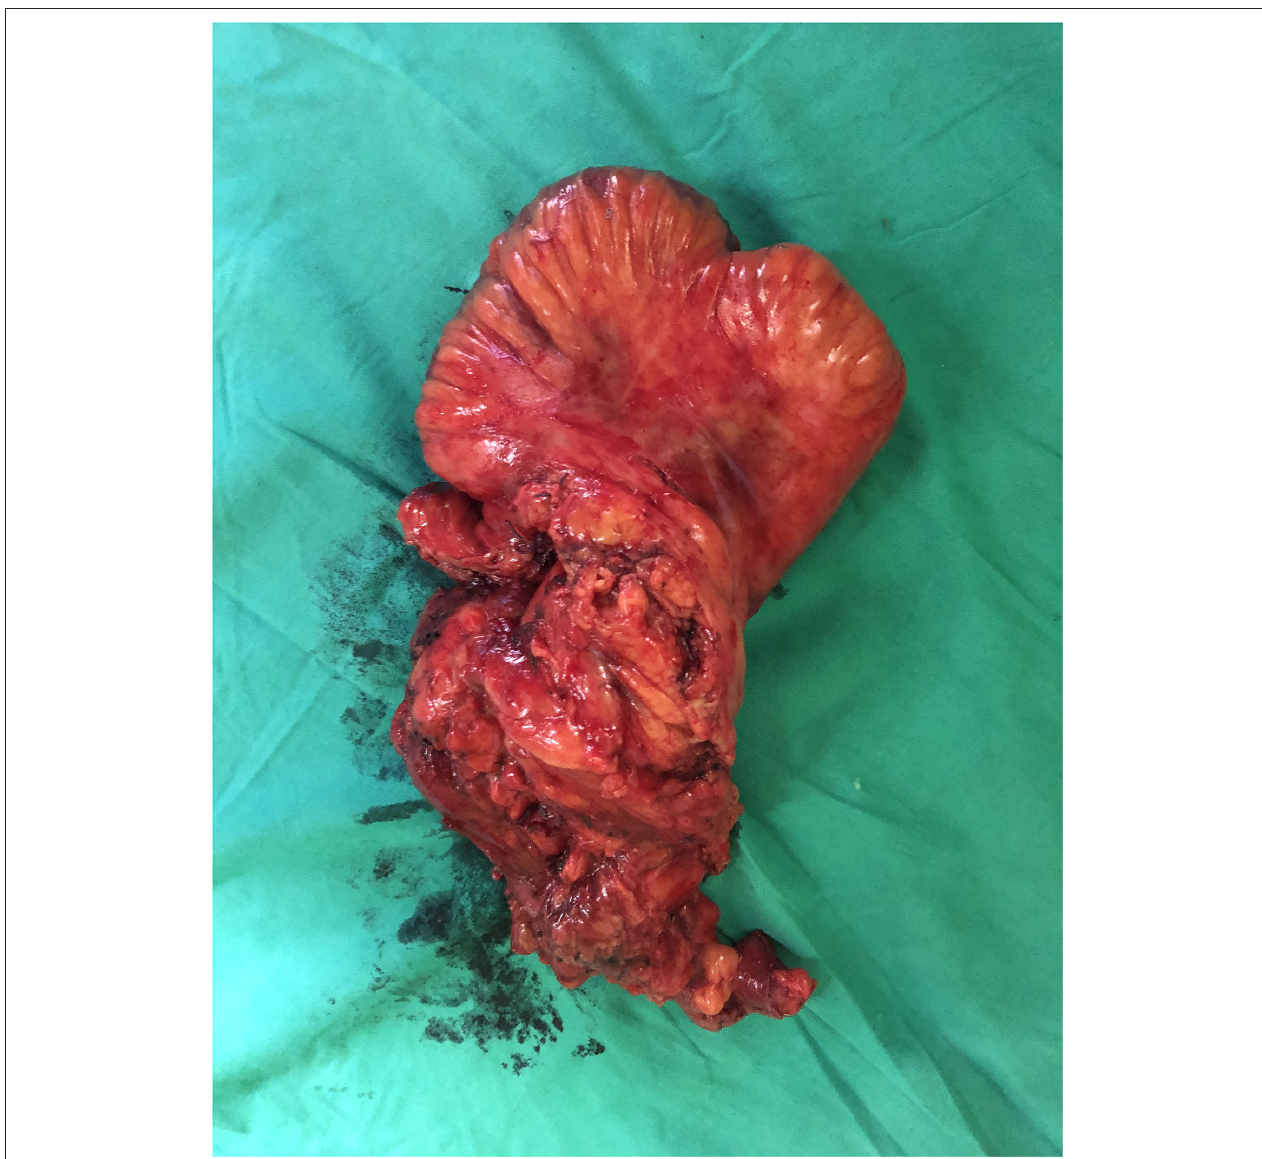
FIGURE 2 | Resection of the ileal segment involved (shown in Figure 1 ) in the ECF with a wide mesenteric margin. A side-to-side (functional end to end) stapled anastomosis was performed to achieve bowel continuity. Significant inflammatory changes were observed in the mesentery. The patient was prescribed low-dose metronidazole for 3 months. The patient is asymptomatic to